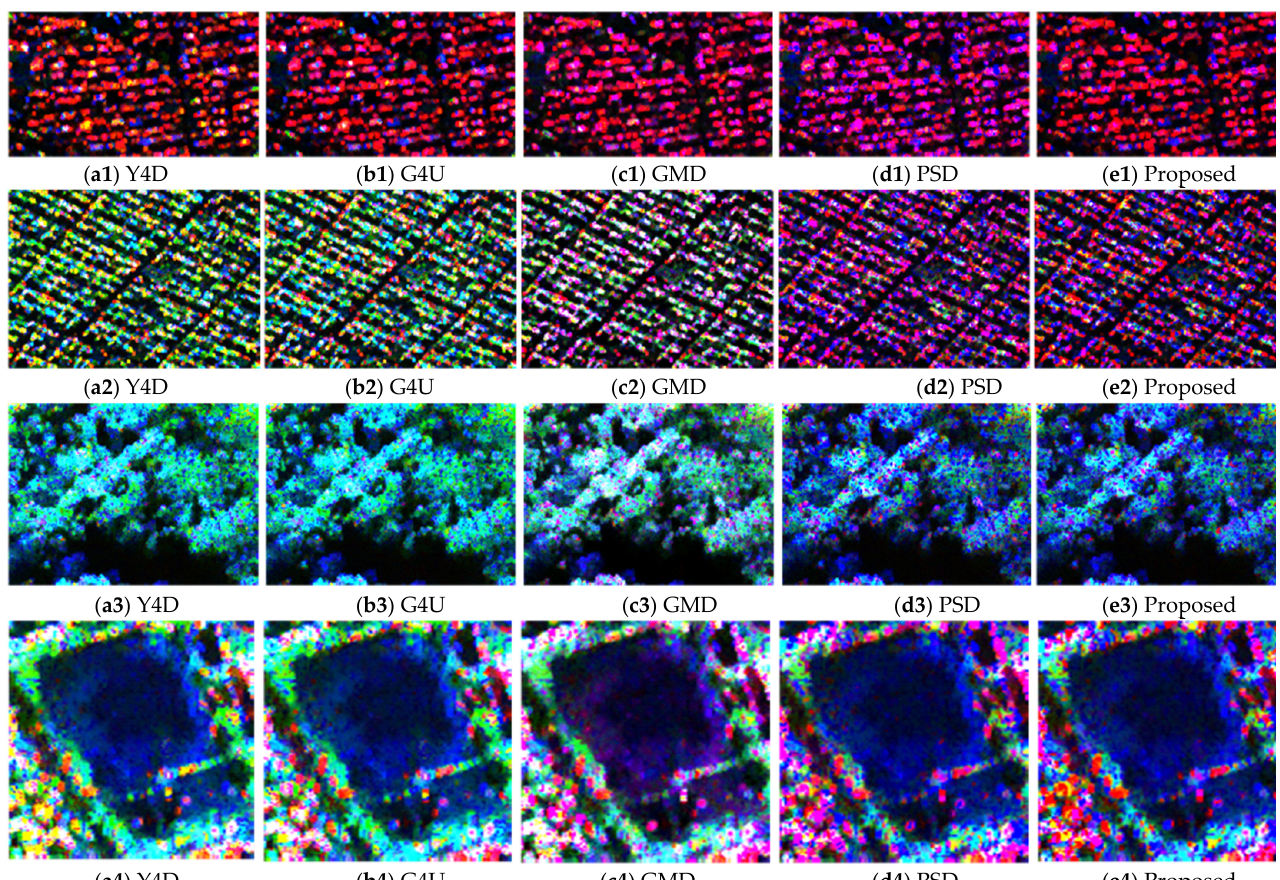
Figure 4. Decomposition results of PiSAR data. ( a , b ) are the optical image and Pauli image of the whole scene. The size is 1400 × 1400 pixels. ( c – g ) are the results of Y4D, G4U, GMD, PSD, and the proposed method. The images are colored by Pd (red), Pv (green), and Ps (blue).